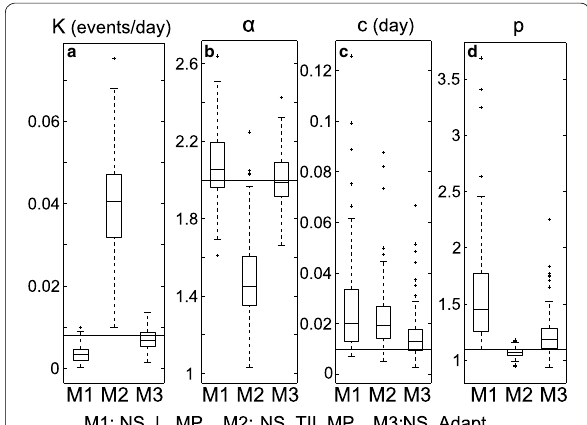
Fig. 4 Box plots of estimated model parameters for the Omori’s law- type synthetic datasets. The box plots of model parameters estimated for the 100 synthetic catalogs using each of the models NS_L_MP, NS_TII_MP and NS_Adapt are shown. The true values of the respec- tive parameters are plotted as horizontal lines